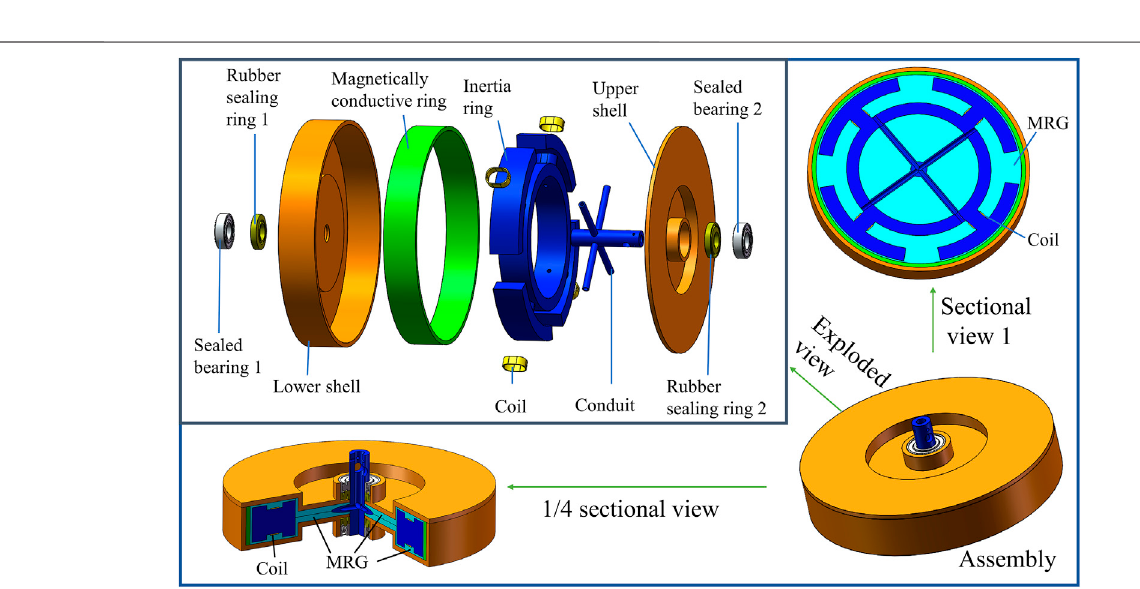
FIGURE 4 | MRG torsional vibration damper